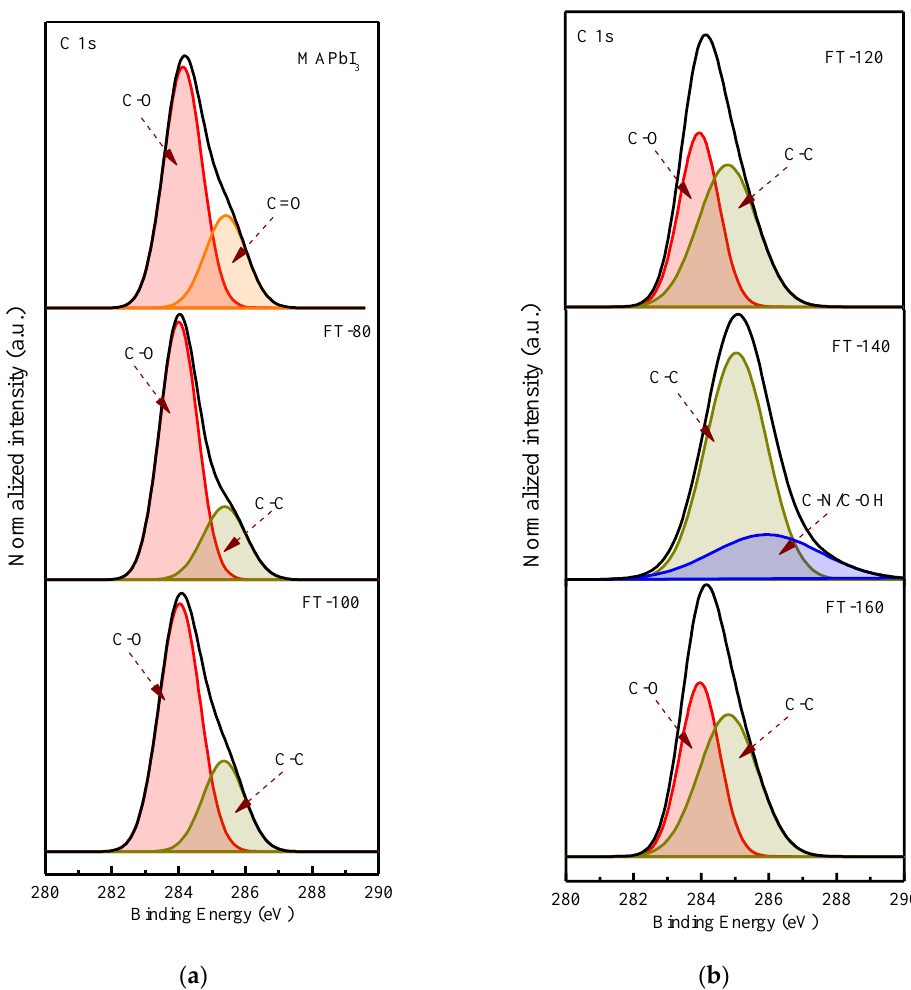
Figure 3. XPS core-level spectra of C 1s ( a ) Pristine MAPbI 3 and CsPbI 3 -QD doped MAPbI 3 under different filming temperatures (FTs) from 80 to 100 ° C. ( b ) CsPbI 3 -QD doped MAPbI 3 under different filming temperatures (FTs) from 120 to 160 ° C